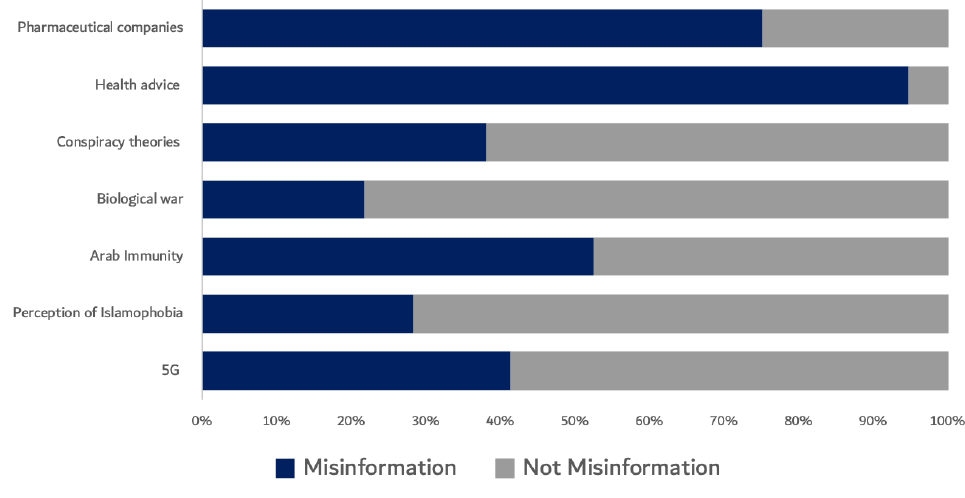
Figure 1. Distribution Of Misinformation Across